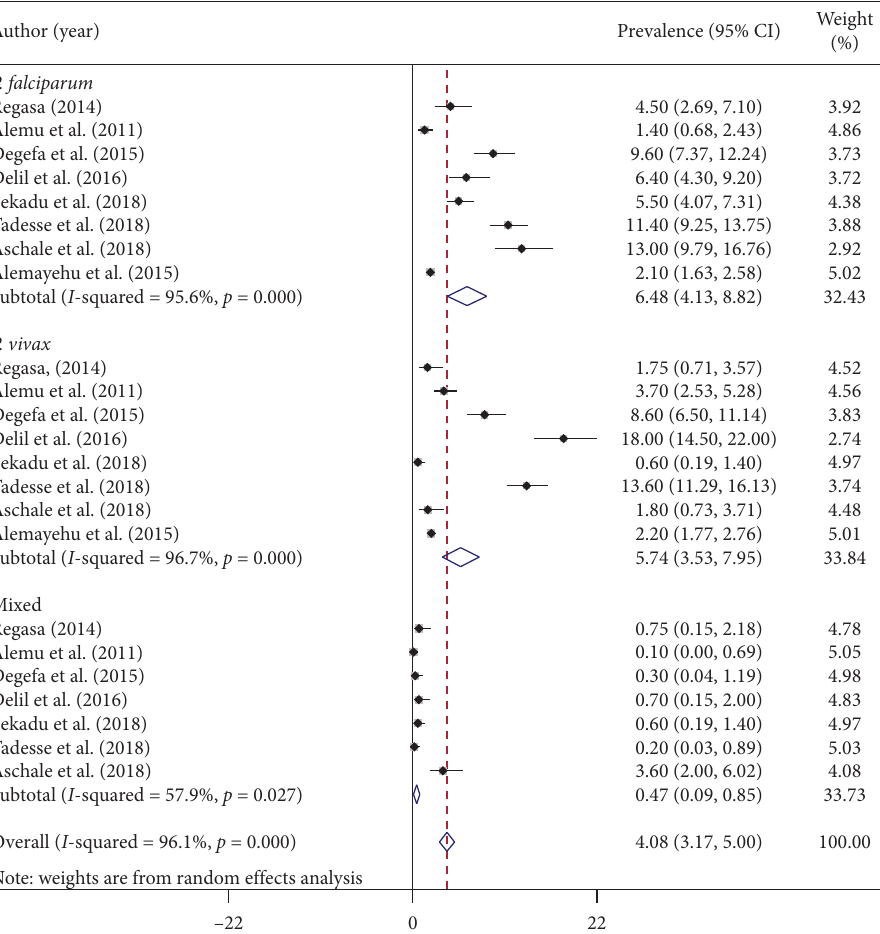
Figure 4: Forest plot showing malaria pooled prevalence estimate among adults by Plasmodium parasites in Ethiopia, 2020.